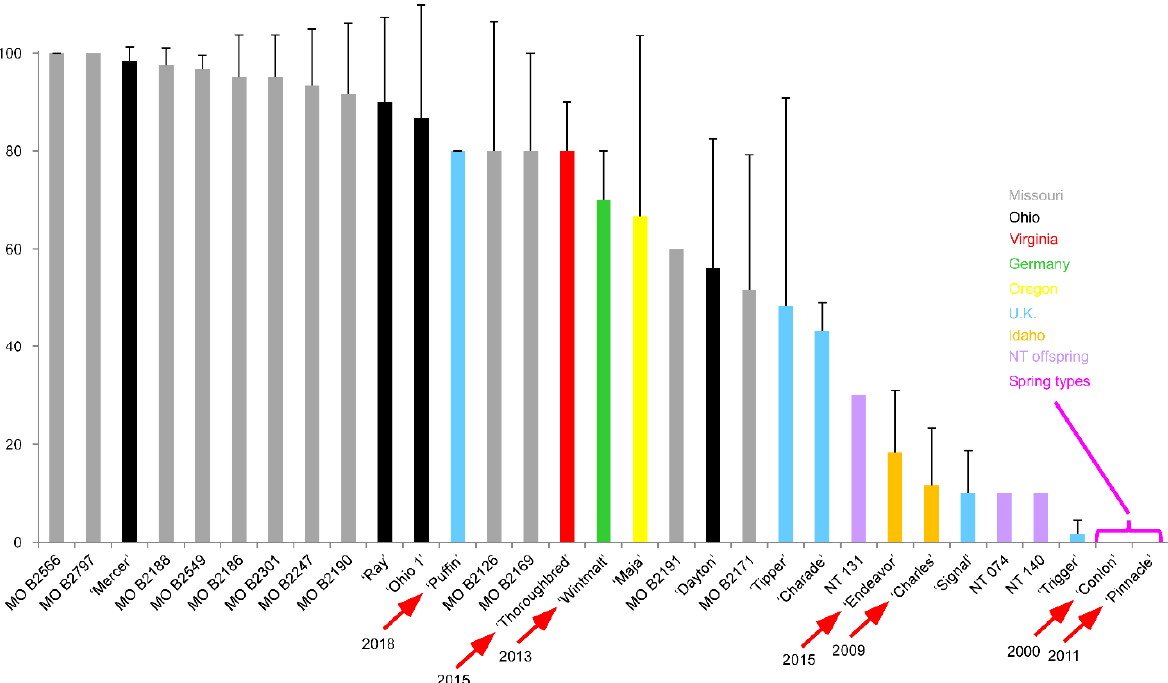
Figure 3. Percent survival 2013–2014. Plants were grown in 1.5 m × 3 m plots, planted seven rows across spaced 19 cm apart per plot in Wooster Ohio. Values are the percent living green plants relative to the total living + dead (brown) plants counted in May 2014 following green up per plot. Error bars show stand counts from three independent plots planted in randomized complete block design, except MO B2191, MO B2797, and the three N × T lines, which were each in a single plot. Color coding is used to represent material from different breeding programs. Red arrows identify AMBA-recommended malting barley lines and the year first recommended.